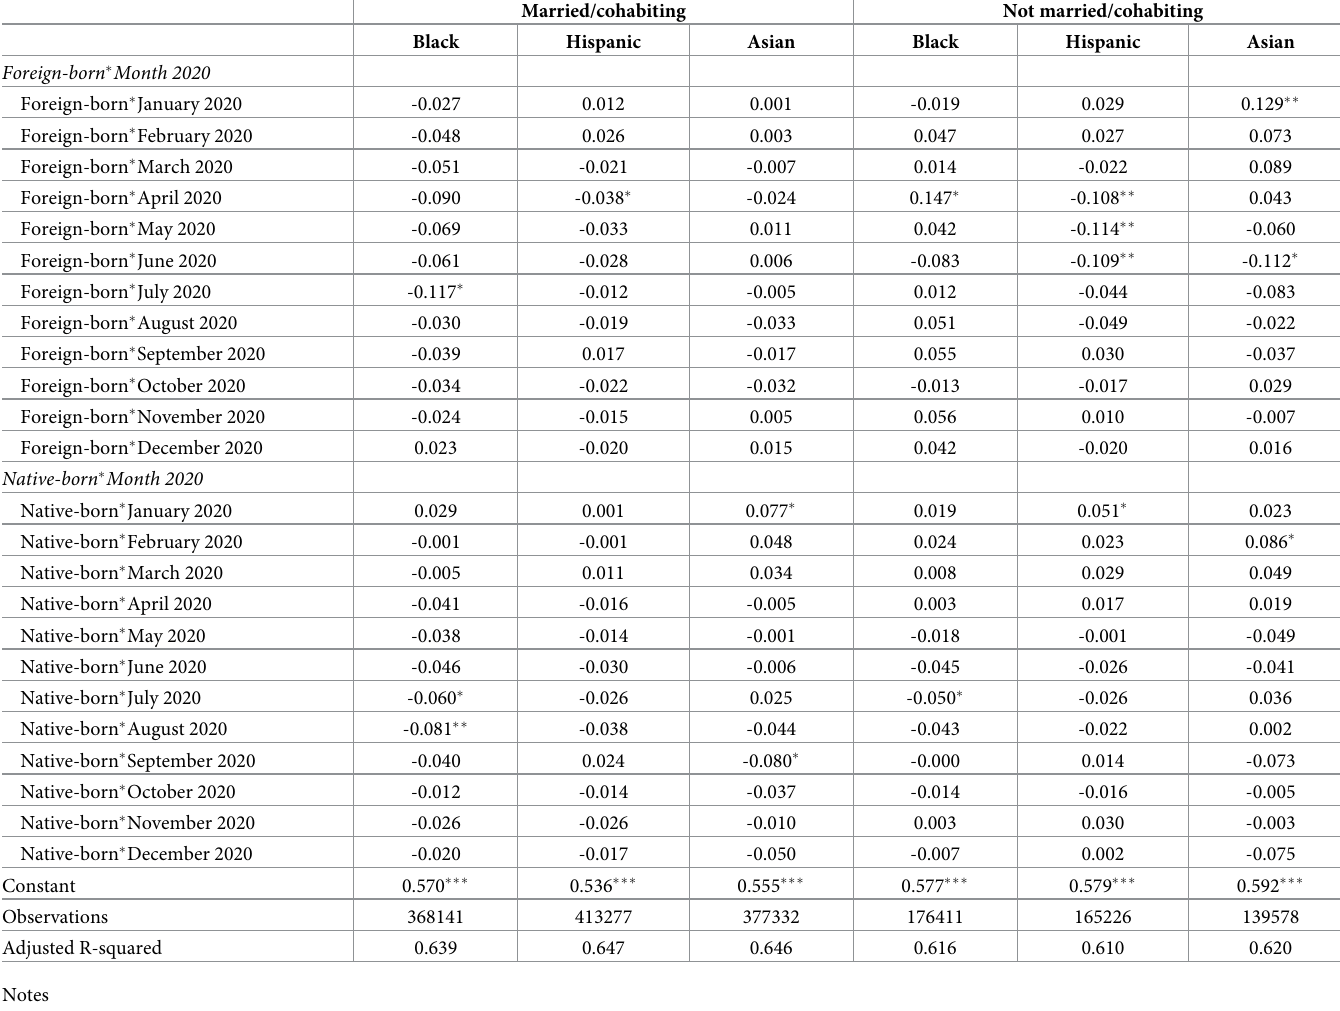
Table 2. Difference in the probability of women’s full-time employment relative to native-born Whites by immigrant status, race/ethnicity and marriage/cohabita- tion in 2020 relative to